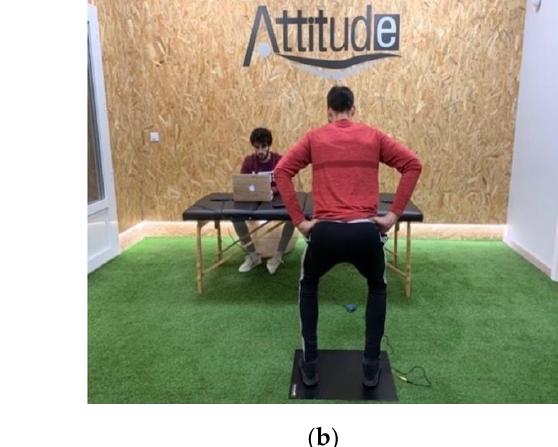
Figure 3. Squat performance speed assessment.